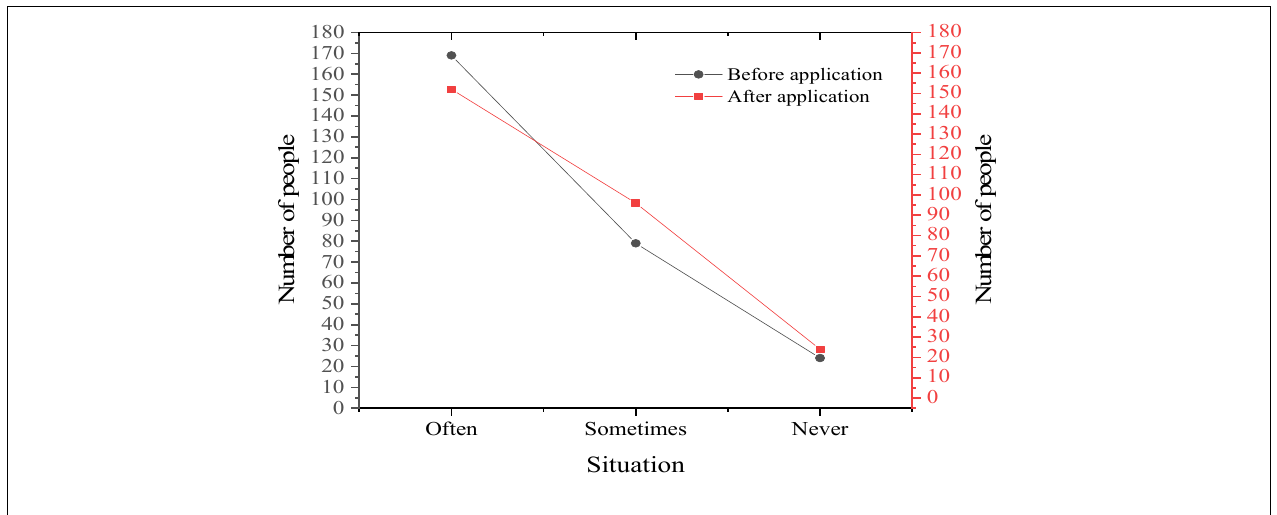
FIGURE 11 | Situation of students before and after using film